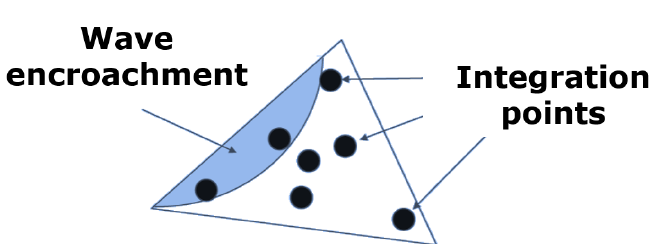
Figure 3. Exemplification of integration inaccuracy due to the wave